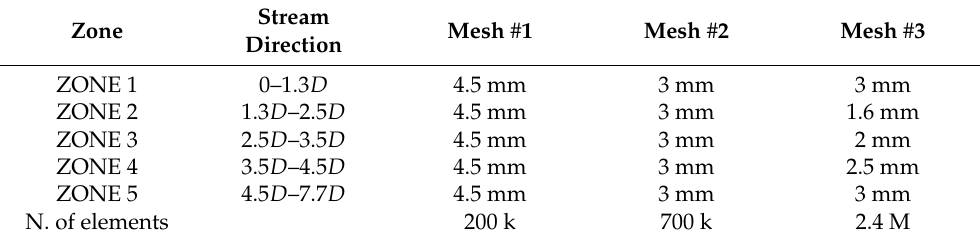
Table 2. Summary of the grid refinement strategy applied in this work. For each zone, the cell dimension is reported ( D is the bluff body